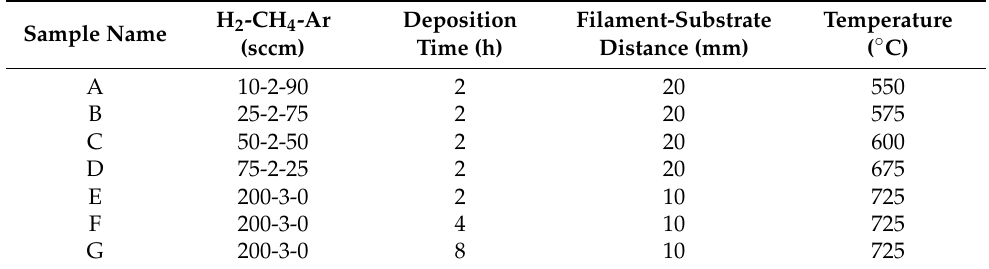
Table 1. Process parameters used for the growth of different PDC films on silicon (Si) substrates. Column 1 shows the cross-referenced name use for each